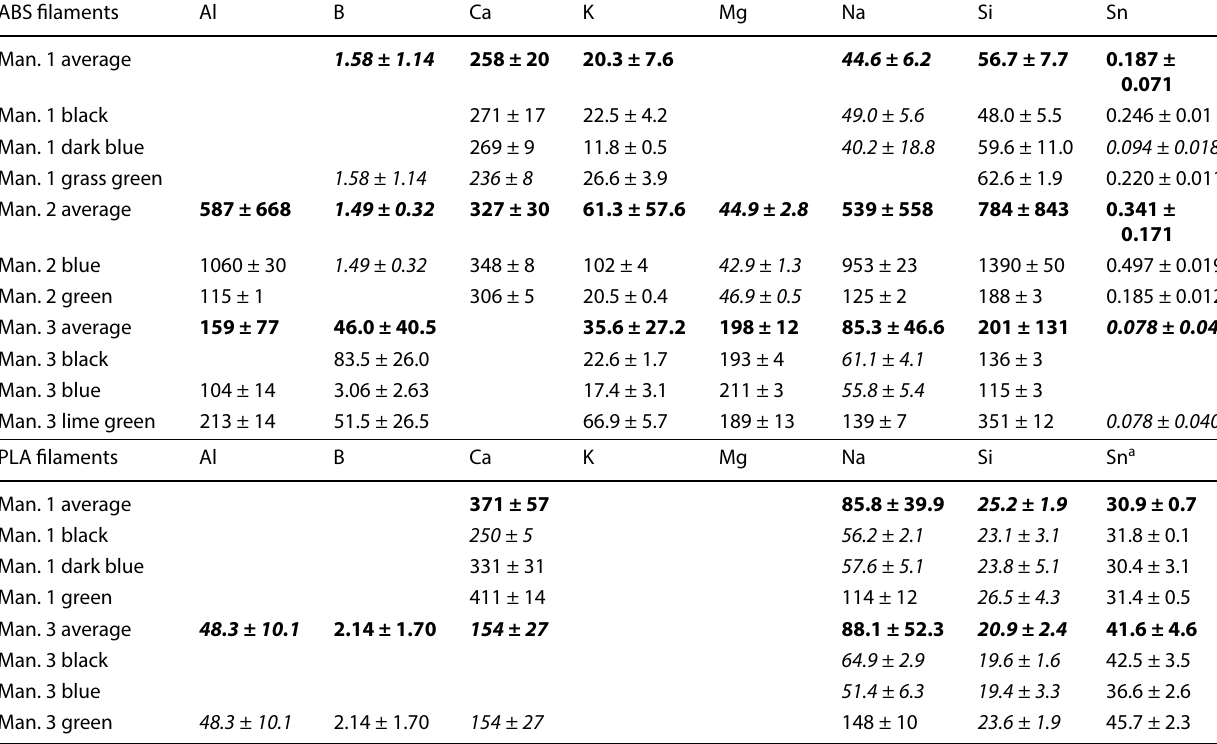
Table 2 Average concentrations (in μg/g) of select elements from 3 to 5 replicates of HPHT digestion of colored ABS and PLA filaments